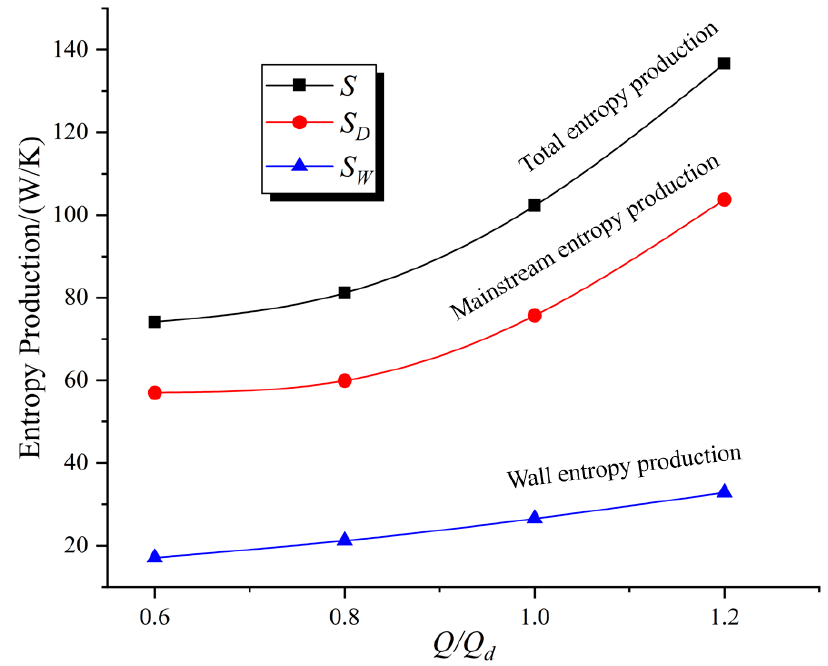
Figure 12. The trends of entropy production under di ff erent fl ow rates.